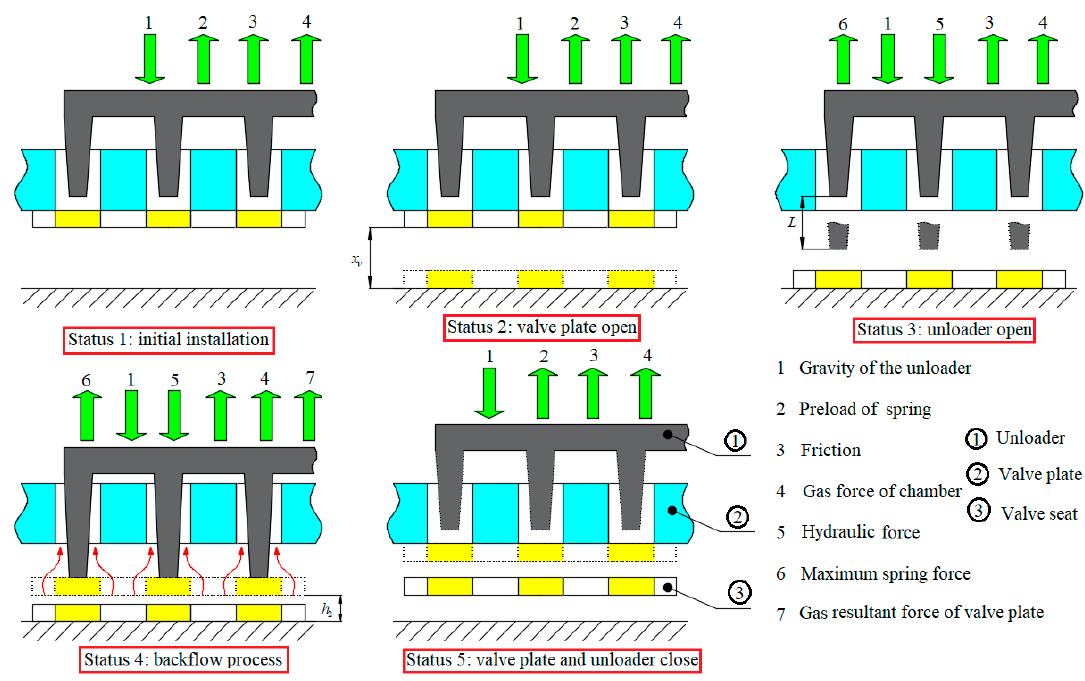
Figure 2. Displacement diagram of valve plate and actuator.